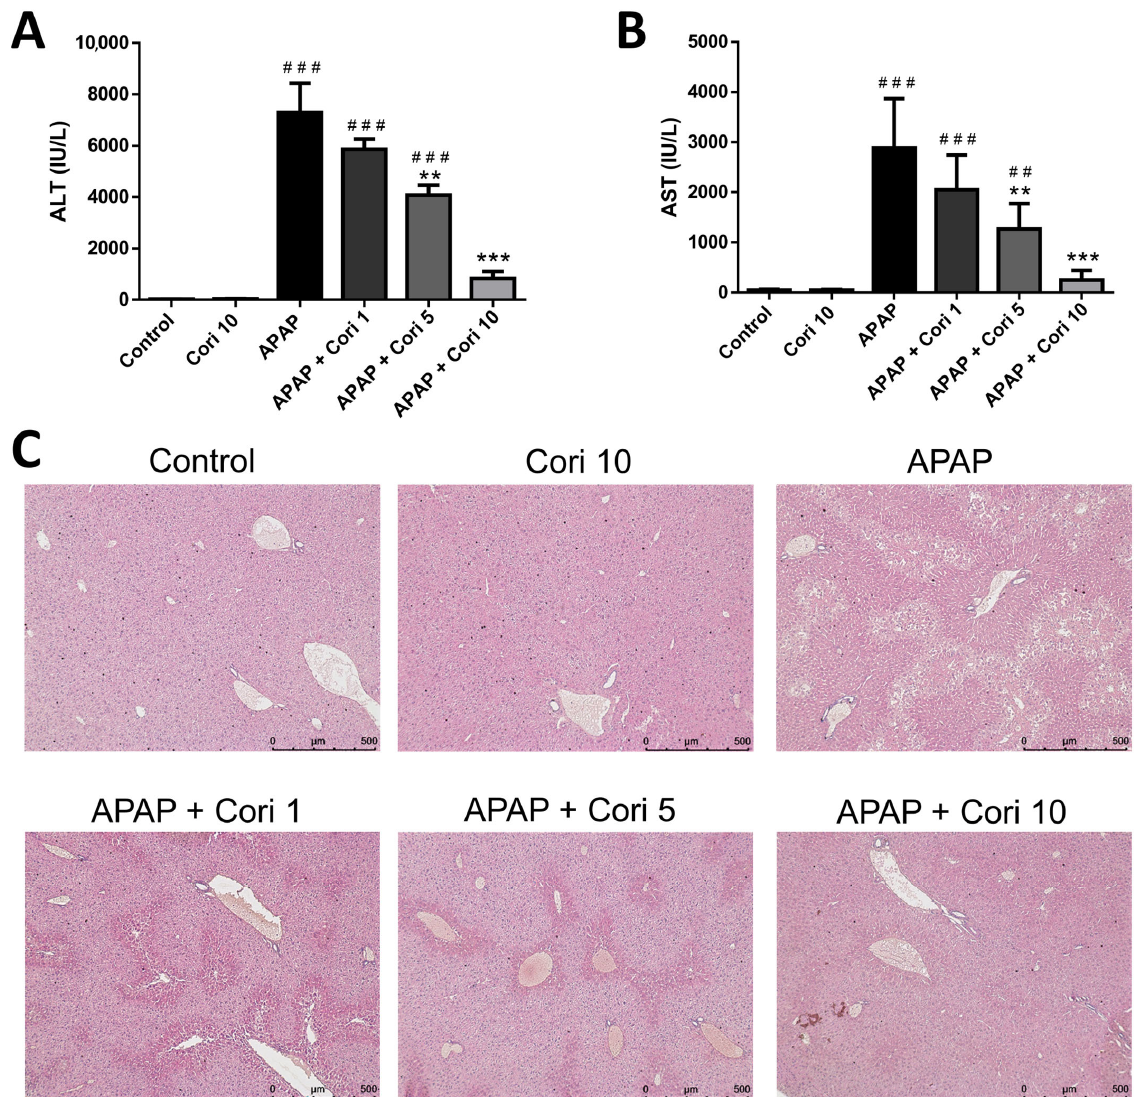
Figure 1. The effects of corilagin on serum ALT levels (A), AST levels (B), and histopathological changes (C) in acetaminophen ‐ induced hepatic injury. Mice were injected with APAP (300 mg/kg) or equal volume of saline (control), and treated with corilagin (0, 1, 5, or 10 g/kg) after 30 min. Each value represents mean ± SEM; n = 6 for each group. ## p < 0.01, ### p < 0.005 vs. control group; ** p < 0.01, *** p < 0.005 vs. APAP group (50×).